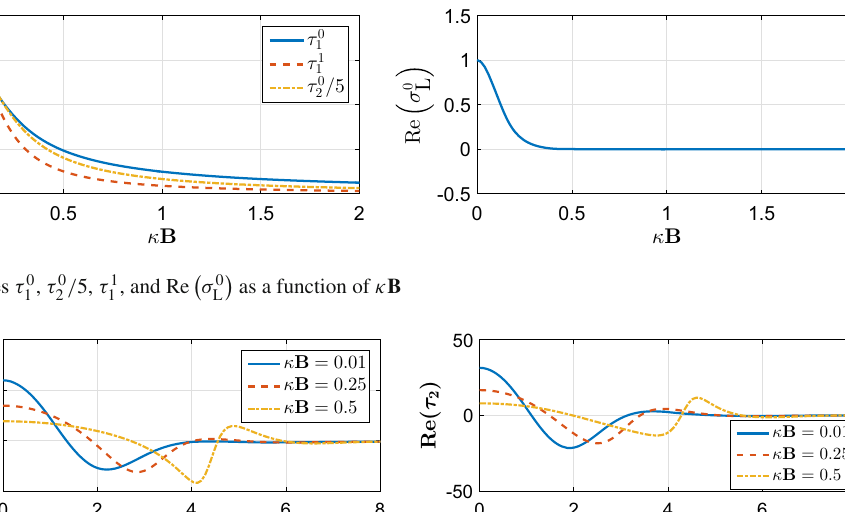
Fig. 1 DC conductivities τ 0